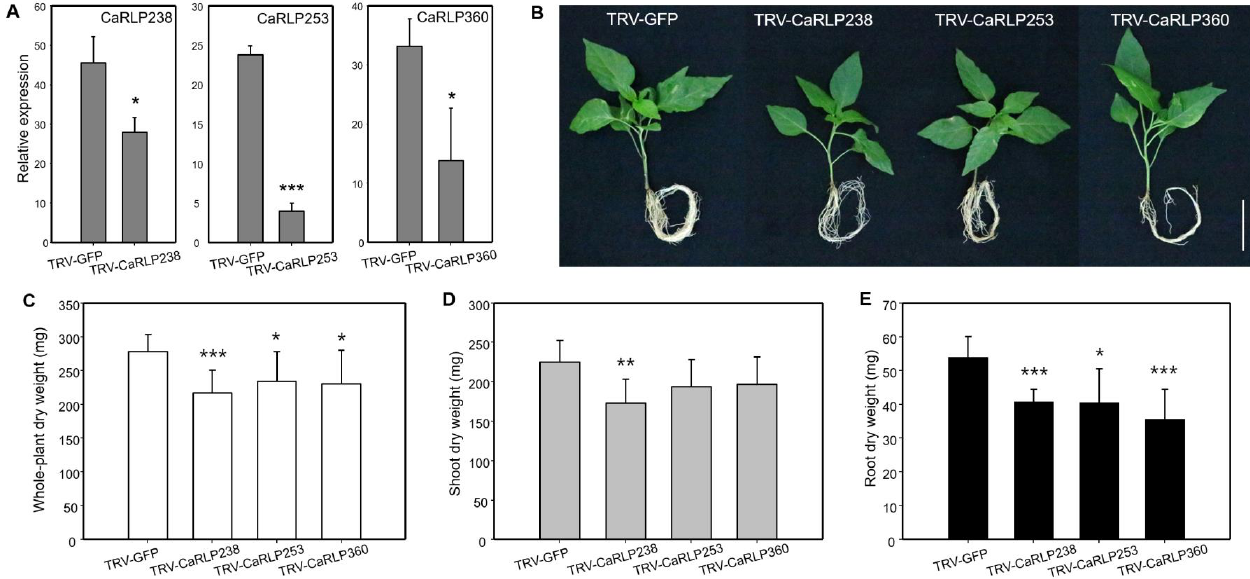
Figure 5. Phenotypic characterization of CaRLP238, 253, and 360-silenced plants. ( A ) Semi-quantitative reverse transcription-polymerase chain reaction (Semi-quantitative RT-PCR) analyses of the each CaRLP ( Capsicum annuum receptor-like proteins) in silenced pepper leaves. TRV-GFP ( Tobacco rattle virus -green fluorescent protein)-treated mock plants were used for VIGS as a reference sample. Expression values were normalized to levels of CaActin gene expression. Data represent mean ± SD (Student’s t-test, * p < 0.05, ** p < 0.01, *** p < 0.0001). ( B ) Phenotype of CaRLP238, 253, and 360-silenced plant and control plants (TRV-GFP). The photo was taken at six weeks after agro-infiltration for a VIGS assay. Scale bar indicates 5 cm. ( C – E ) Comparison of whole-plant dry weight, shoot dry weight, and root dry weight in control plant (TRV-GFP), and CaRLP238, 253, and 360 silenced plants. Data are shown as mean ± SD. Statistically significant differences compared with the TRV2-GFP control determined using Student’s t-test are indicated by asterisks (* p < 0.05, ** p < 0.01, *** p < 0.0001).